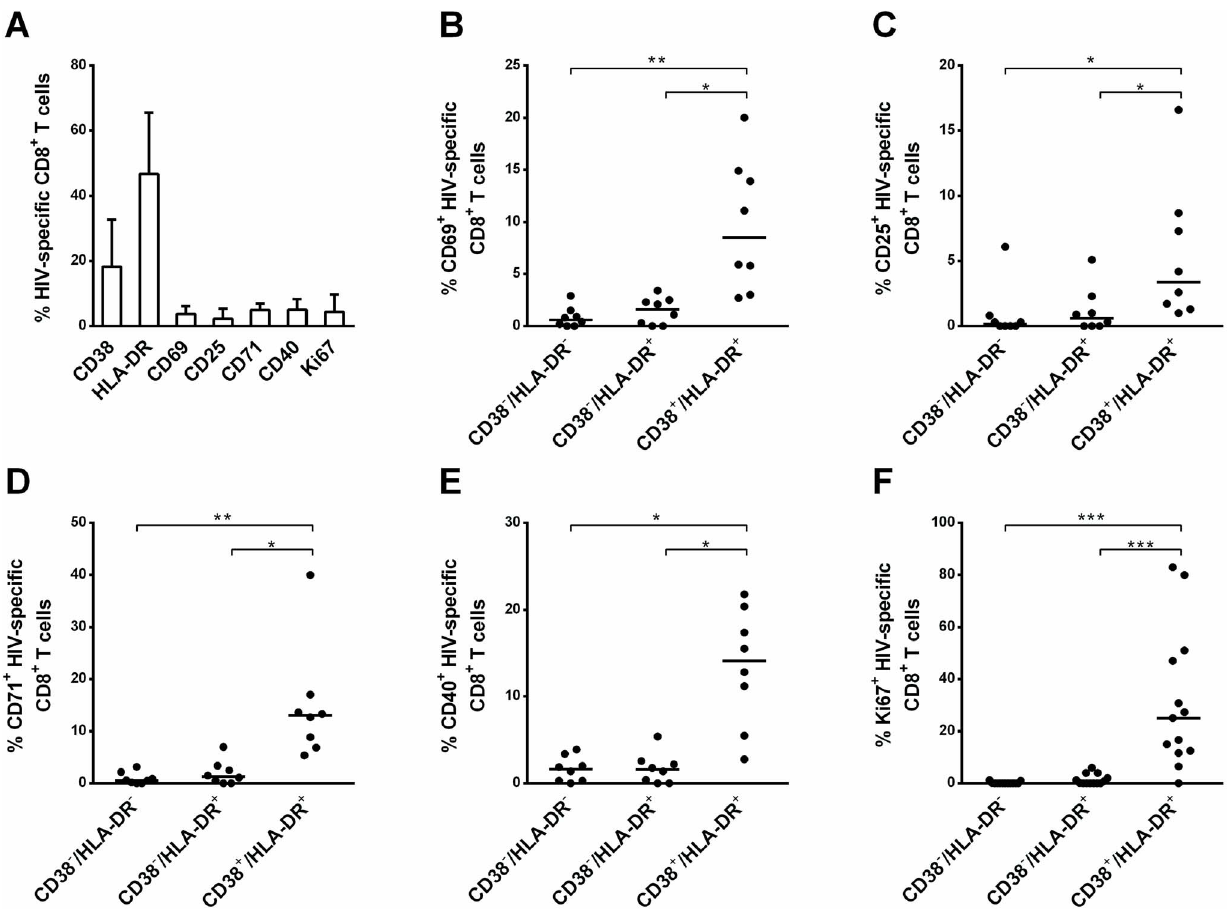
Figure 2. Activation phenotype of CD38 2 /HLA-DR 2 , CD38 2 /HLA-DR + and CD38 + /HLA-DR + subsets from HIC. (A) Proportions of HIV- specific CD8 + T cells expressing CD38, HLA-DR, CD69, CD25, CD71, CD40 and Ki67. (B–F) Proportions of CD38 2 /HLA-DR 2 , CD38 2 /HLA-DR + and CD38 + /HLA-DR + HIV-specific CD8 + T cells expressing CD69 (B), CD25 (C), CD71 (D), CD40 (E) and Ki67 (F) (n=8). * P , 0.05, ** P , 0.01, *** P , 0.001.